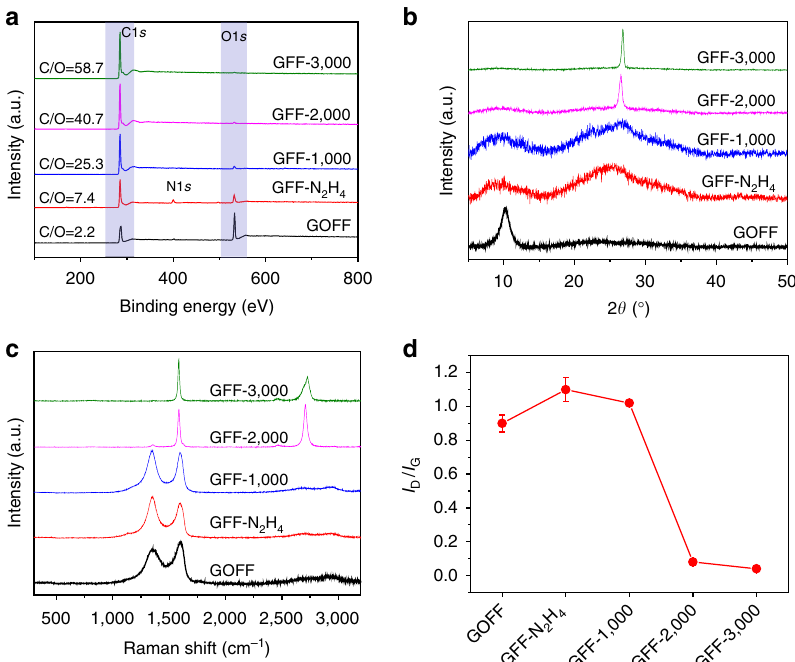
Figure 3 | Characterization of GOFFs and GFFs. ( a ) XPS spectra of the as-prepared GOFF, N 2 H 4 reduced GFF and thermally annealed GFFs at 1,000, 2,000 and 3,000 (cid:2) C. ( b ) X-ray diffraction patterns of GOFF, GFF-N 2 H 4 and annealed GFFs. ( c ) Raman spectra of GOFF, GFF-N 2 H 4 and annealed GFFs. ( d ) Variation of I D / I G in different samples. Error bars represent the s.d. of I D / I G for at least five